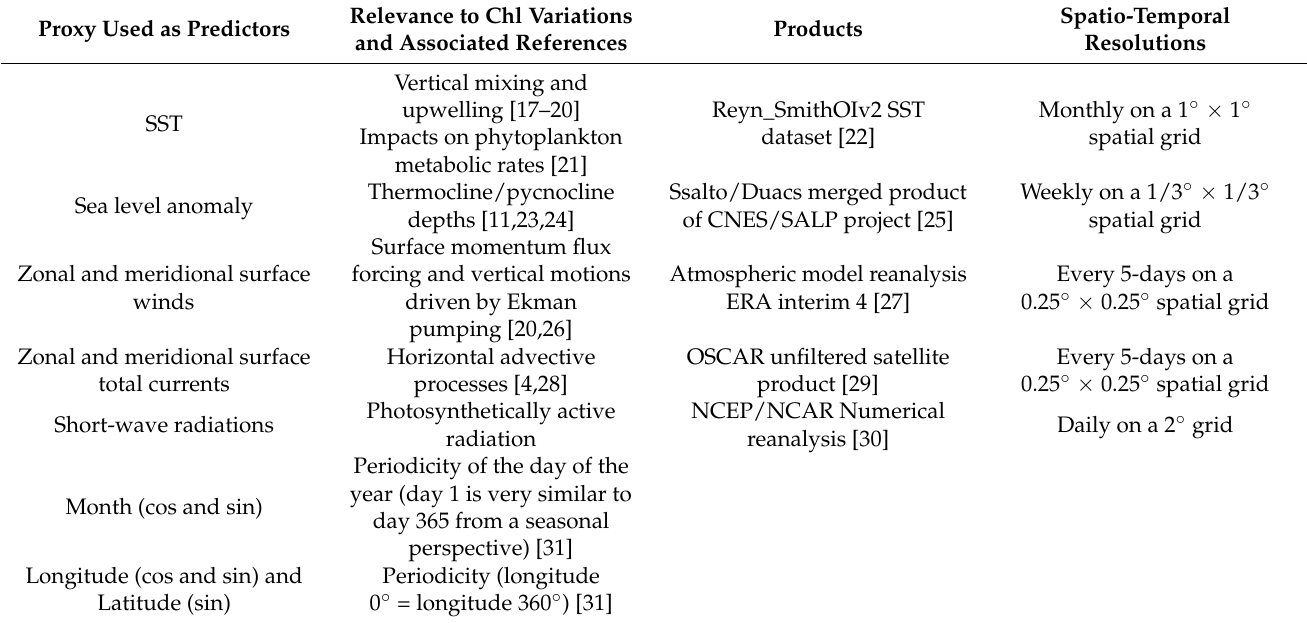
Table 1. Physical predictors, their relevance to Chl variability, the products used, and their resolution.